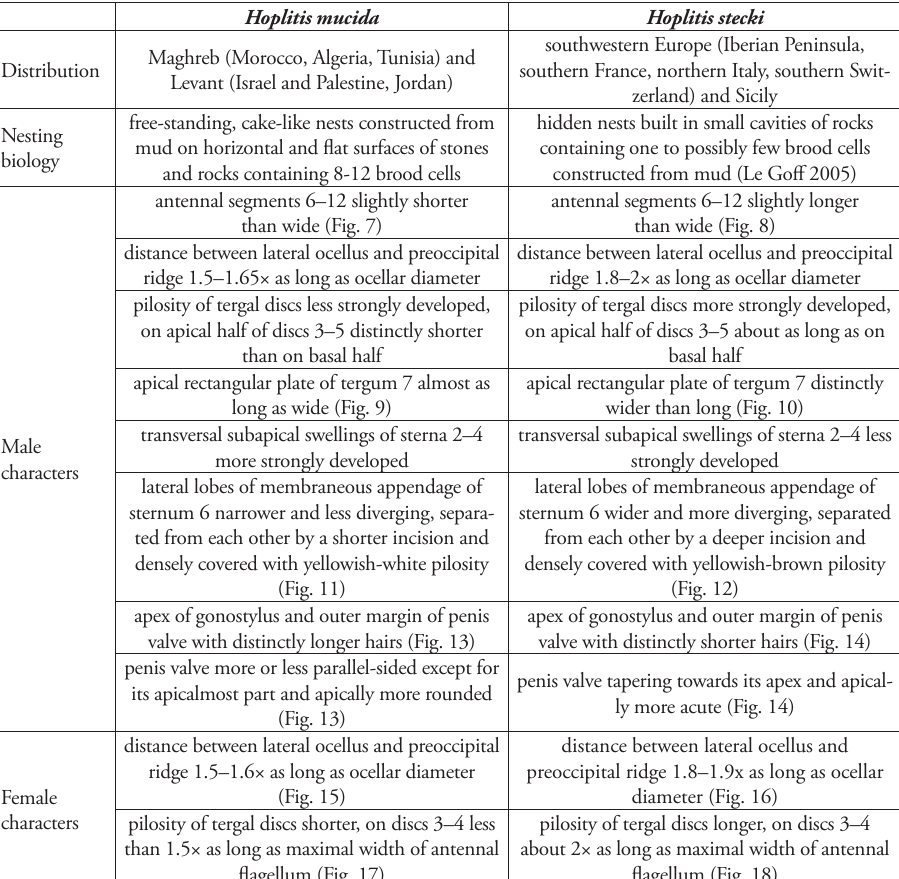
Table 2. Biological and morphological differences between Hoplitis mucida (Dours, 1873) and H. stecki (Frey-Gessner,